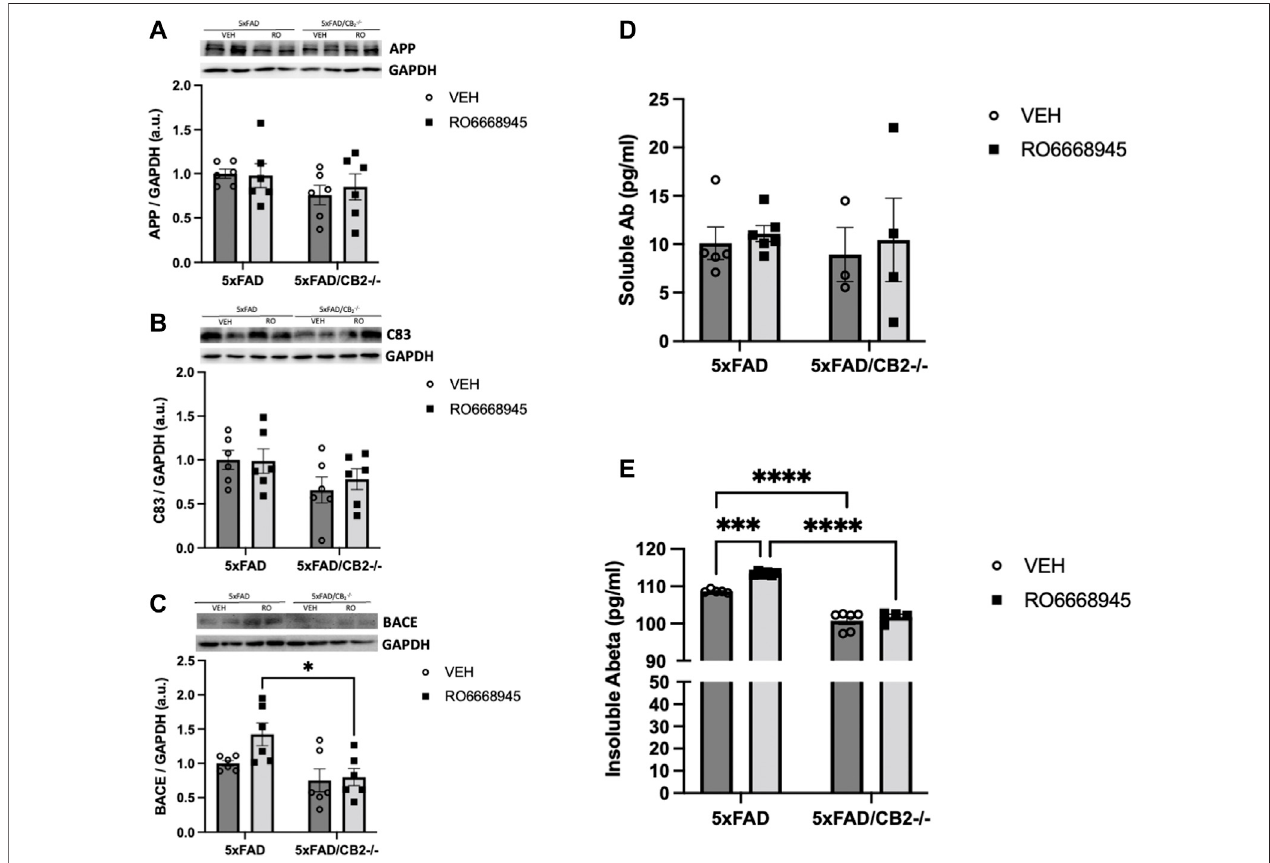
FIGURE 6 | Cannabinoid CB 2 receptors modulate amyloid dynamics in vivo . No changes were evident after treatment in APP (A) , C83 (B) or BACE1 (C) , as measured by western blot. Soluble amyloid levels (D) remained also unaltered, while those of insoluble amyloid (E) were signi fi cantly increased by the exposure to the CB 2 agonistanddecreasedin5xFAD/CB 2-/- mice.Two-way ANOVAfollowedbyTukey ’ spost-hoctest.* < p 0.05;**** < p 0.0001.N=4-6micepergroup.Datarepresent mean ±